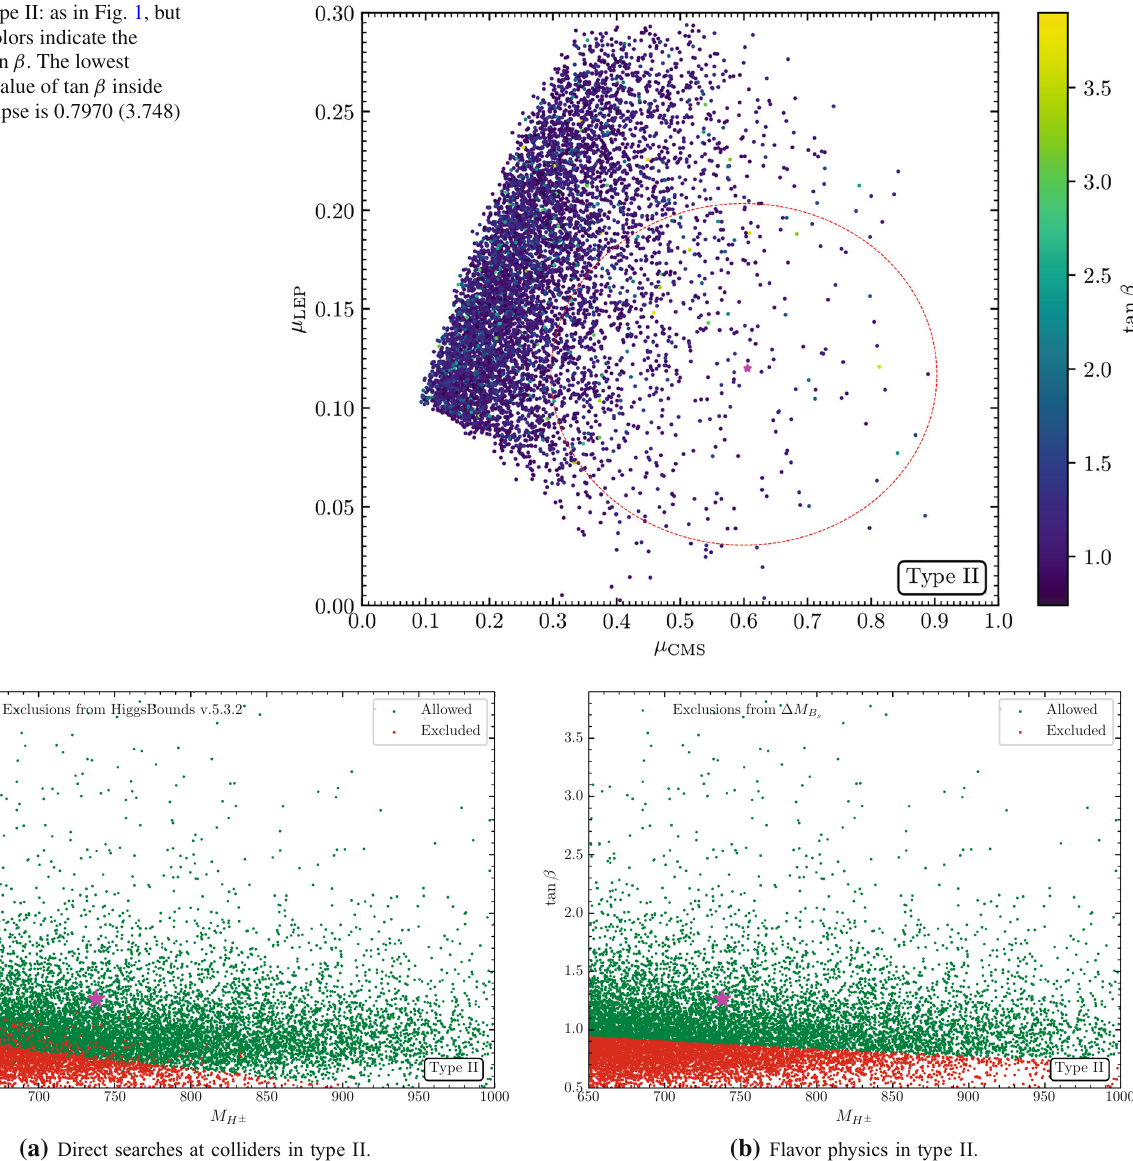
Fig. 4 Allowed ( green ) and excluded ( red ) points considering direct searches ( left ) and flavor physics ( right ) in the M H ± -tan β plane. The magenta star is the best-fit point